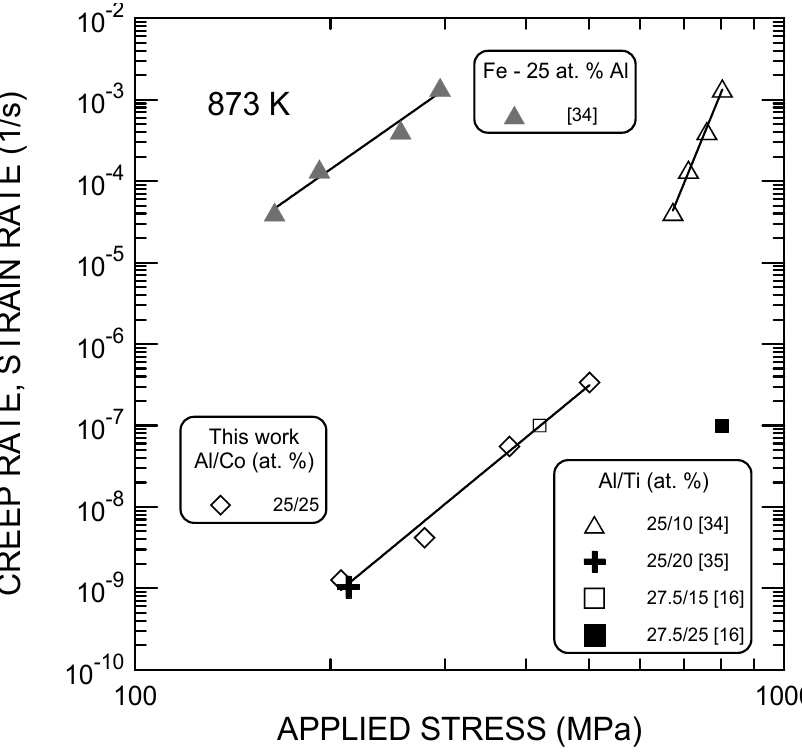
Figure 5. Comparison of creep rate/strain rate variation with applied stress for the present alloy, binary Fe–Al alloy and Fe–Al–Ti alloys at 873 K.